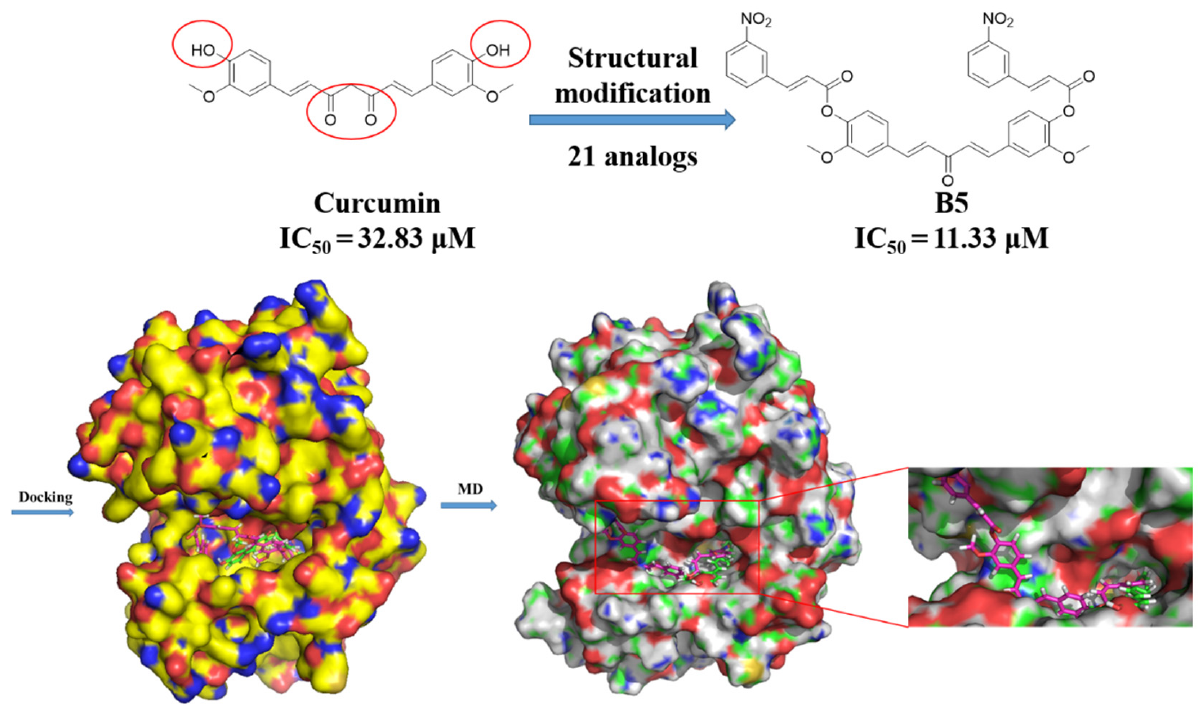
Figure 6. Interactions pattern between small molecules (curcumin and B5 ) and AKT protein showed the electrostatic surface in the 3D representation from molecular docking. Curcumin (green) and B5 (pink) were represented in sticks and colored by atom type.